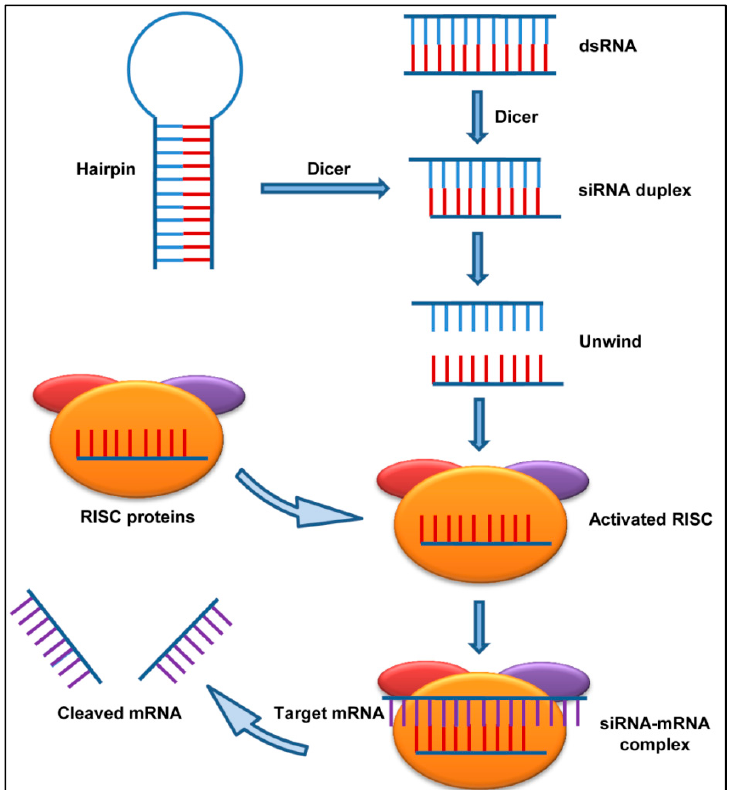
Figure 1. Mechanism of action of short interfering RNAs (siRNA): The presence of a double stranded RNA as a consequence of viral infection triggers RNA interference (RNAi). The host enzyme Dicer binds to double-stranded RNA (dsRNA) and cleaves it into short pieces of ∼ 20 nt called